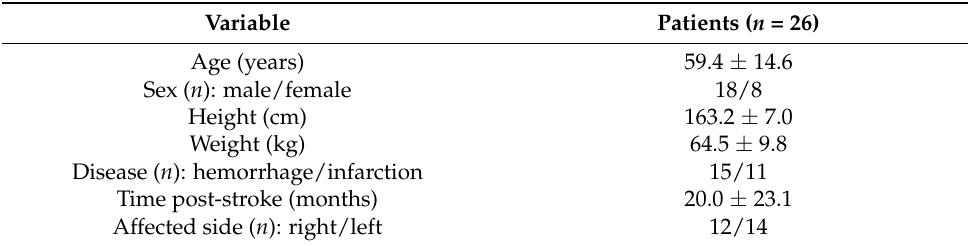
Table 1. Clinical characteristics of study